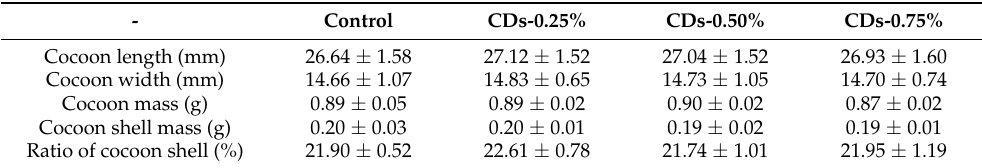
Figure 4. External appearance of the cocoons of the control and CD groups. Table 1. Effect of CDs on the silk yield of silkworms.